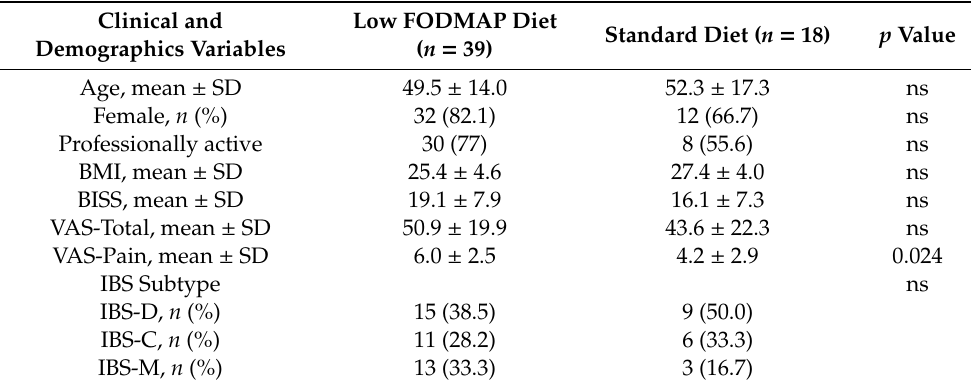
Table 1. Baseline characteristics.